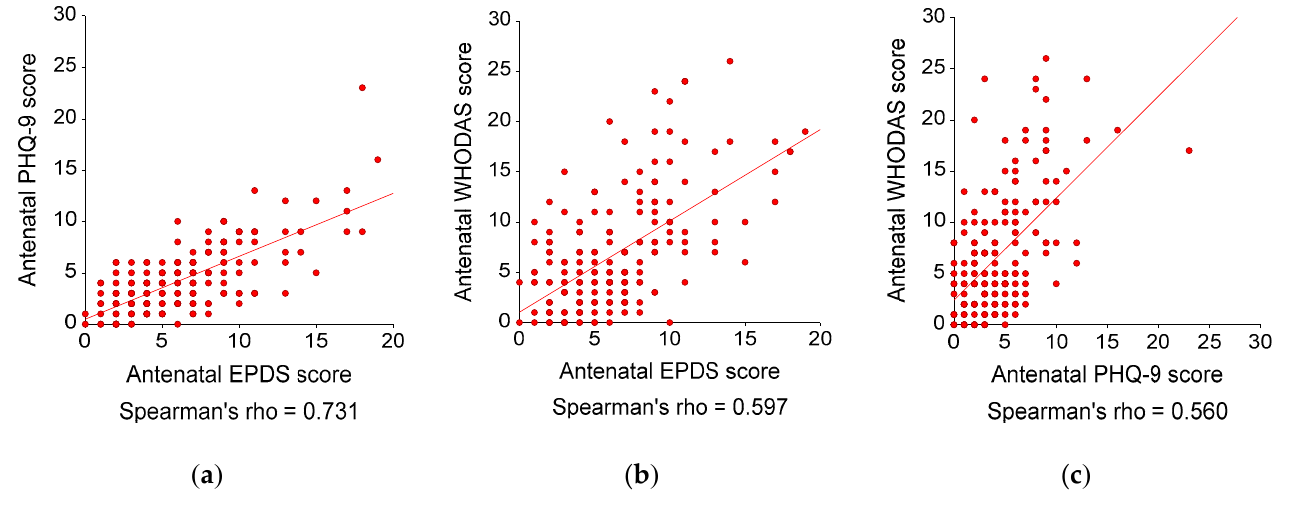
Figure 1. Correlations among EPDS, PHQ-9, and WHODAS scores and regression lines in 186 pregnant participants (antenatal data only): ( a ) Correlation between antenatal EPDS and PHQ-9 score s: Spearman ’s rho (95% CI ; p -value ) = 0.73 (0.63, 0.78; p < 0.001; ( b ) Correlation between antenatal EPDS and WHODAS score s: Spearman ’s rho (95% CI ; p -value ) = 0.60 (0.50, 0.68; p < 0.001) ; and ( c ) Correlation between antenatal PHQ-9 and WHODAS score s: Spearman ’s rho (95% CI ; p -value ) = 0.56 (0.45, 0.65; p < 0.001). EPDS, Edinburgh Postnatal Depression Scale; PHQ 9 , 9-item Patient Health Questionnaire; WHODAS, 12-item World Health Organization Disability Assessment Schedule.